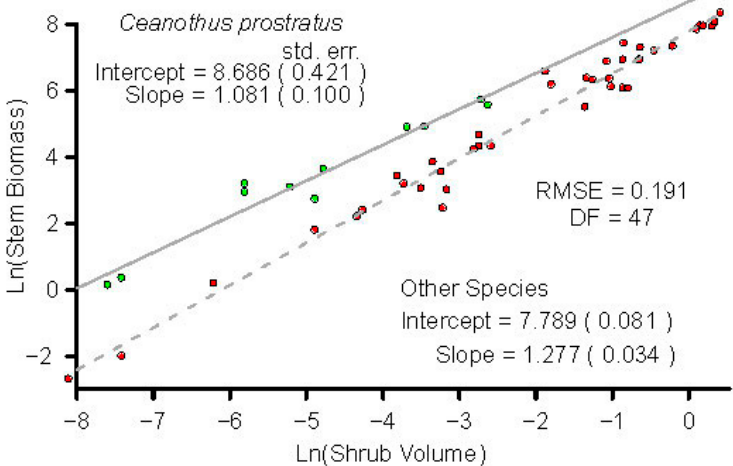
Figure 4. Model fit statistics and uncorrected parameter estimates for aboveground woody biomass (g m − 2 ) in shrubs as a function of shrub volume (m 3 m − 2 ), expressed for Ceanothus prostratus . (green, solid line) and other species (red, dashed line).